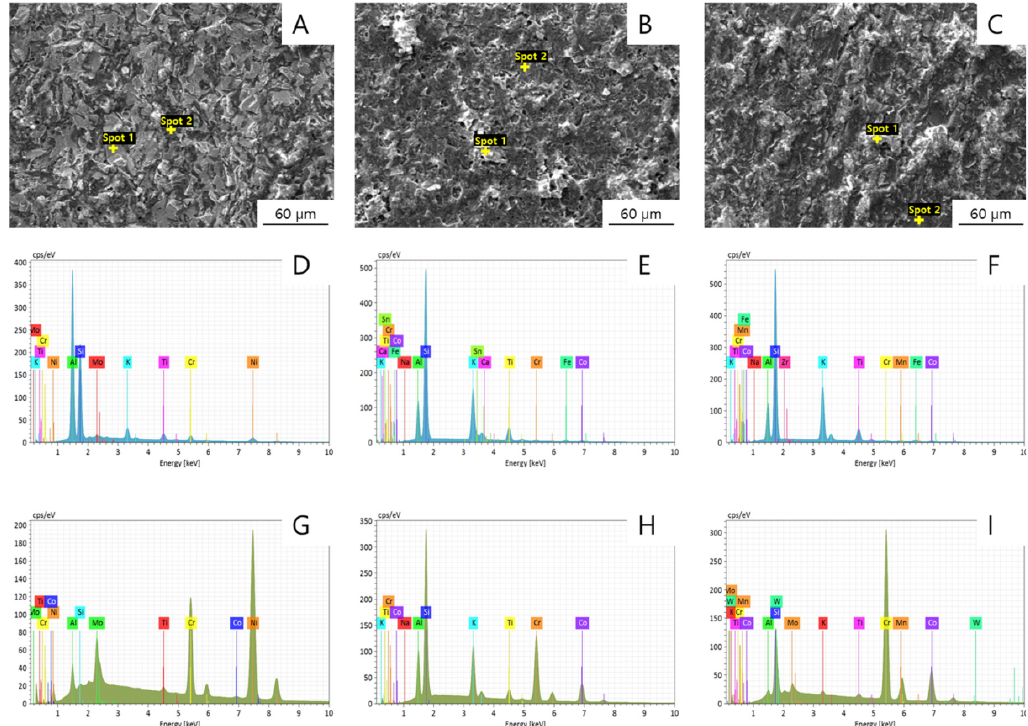
Figure 12. ( A – C ) SEM images (1000 × ) of ( A ) casting, ( B ) milling, and ( C ) SLM specimens. ( D – I ) EDX spectra of the Co-Cr alloy surface after removal of the ceramic layer: ( D – F ) spot 1 of the ( D ) casting, ( E ) milling, and ( F ) SLM specimens, and ( G – I ) spot 2 of the ( G ) casting, ( H ) milling, and ( I ) SLM specimens. Table 6 lists the observed Si area ratios. A ratio of 20% or less indicates adhesive failure, whereas a ratio of 80% or more indicates cohesive failure. Ratios between 20% and 80% are regarded to indicate mixed failures. From the results of the analysis, the ratio increased in the following order: casting < SLM < milling. All specimens showed mixed failure